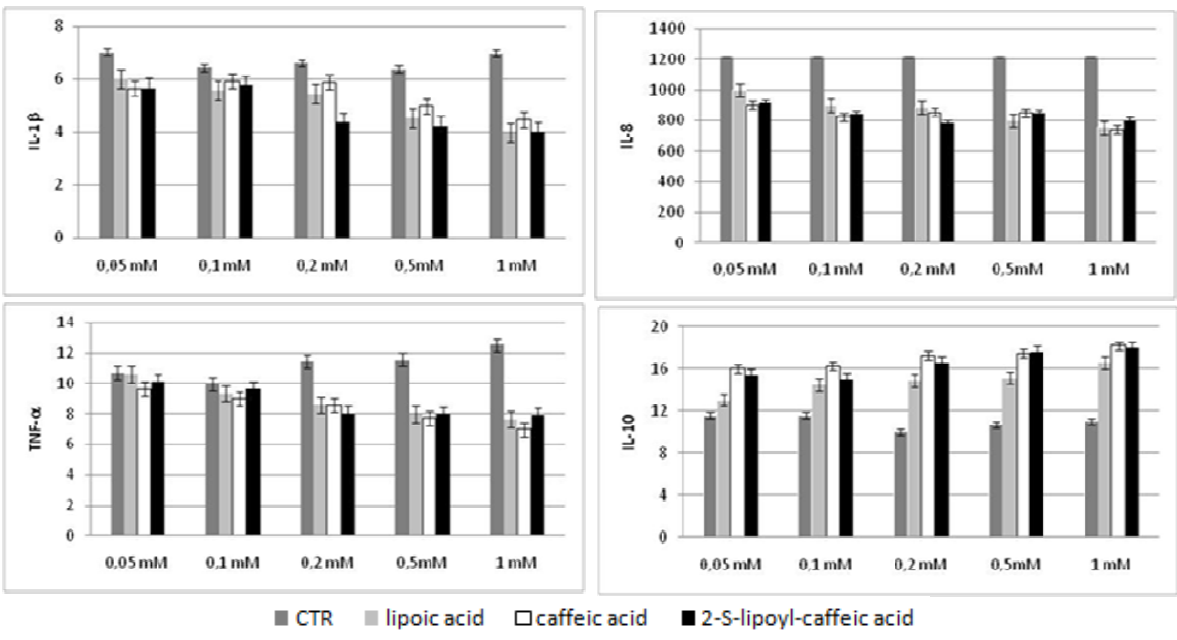
Figure 5. Cytokines levels in Huh7 cell line after 72 h of